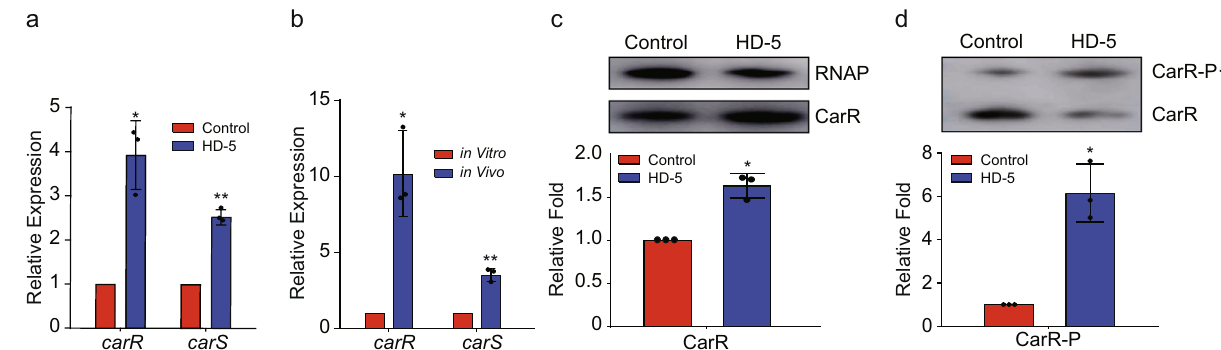
Fig. 3 CarR is activated in response to HD-5. a , b qRT-PCR analysis of carR and carS expression in AKI medium containing 0 and 50 μ g/mL HD-5 ( a ) and in the small intestine of mice ( b ). Data are presented as mean ± SD ( n = 3). c Western blotting and quantitative analysis of CarR in AKI medium containing 0 and 50 μ g/mL HD-5. RNA polymerase (RNAP) was used as a control. Data are presented as mean ± SD ( n = 3). d Phosphorylation status analysis of CarR in AKI medium containing 0 and 50 μ g/mL HD-5. CarR-P phosphorylated CarR, CarR non-phosphorylated CarR. Signi fi cance was determined by